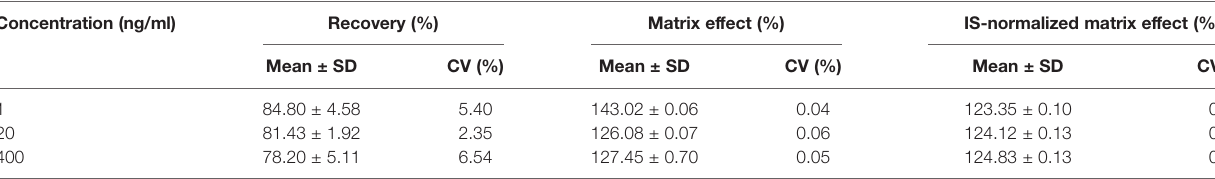
CV, coef fi cient of variation; IS, internal